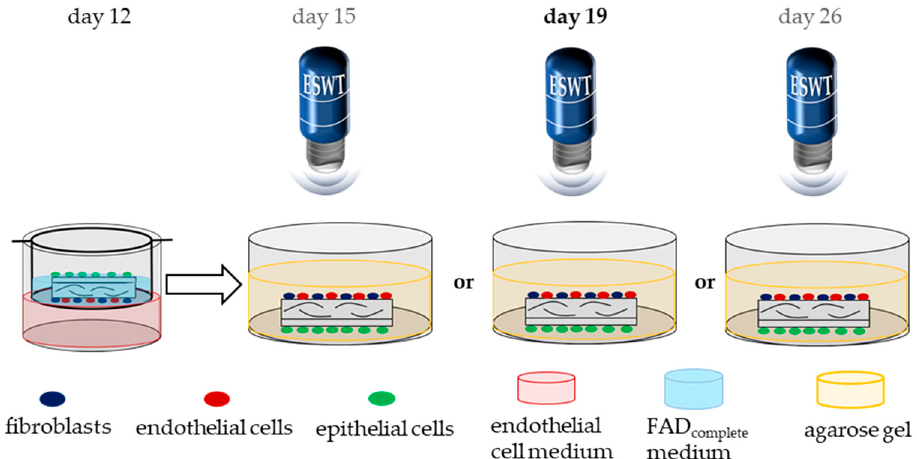
Figure 3. Schematic illustration of the method of application of ESWT to the cell colonized matrices. The cell-colonized matrices were treated with ESWT on day 15, day 19, or day 26 of cell cultivation. After treatment, the tissue equivalents were transferred back into the transwell system until culture day 33. The treatment on day 19 provided the most promising results. Thus, further evaluation of the impact of ESWT on the epithelium and the basement membrane were assessed with the day 19 treatment scheme.